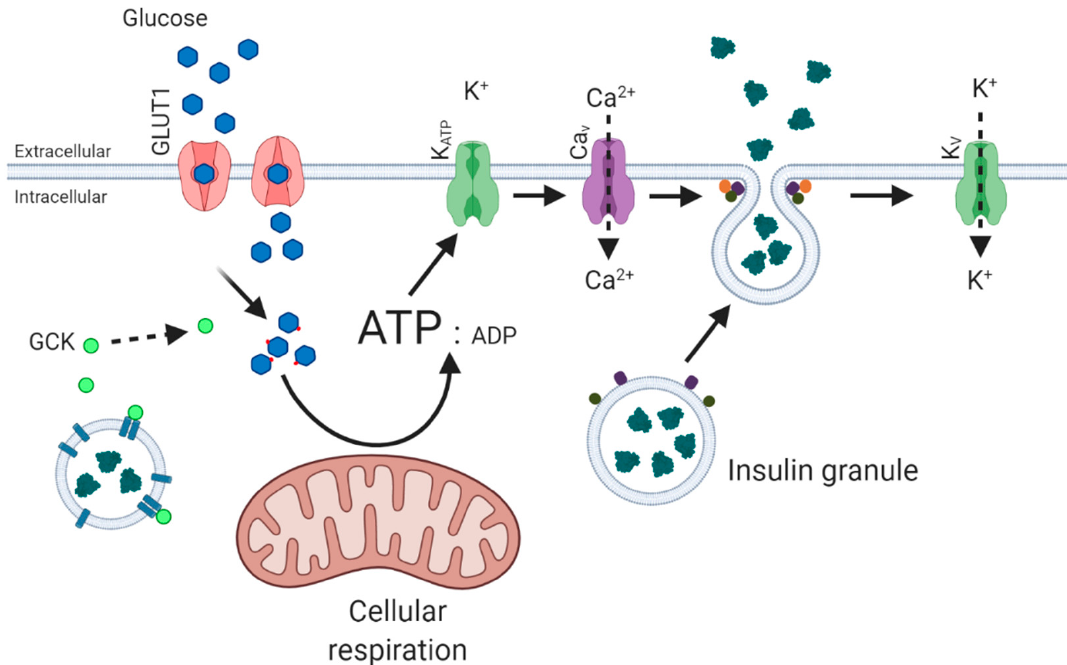
Figure 1. Glucose-stimulated insulin secretion from pancreatic beta cells. Glucose is imported via GLUT1 and phosphorylated by GCK. The increase in cellular respiration leads to an increase in the ATP/ADP ratio and the closure of K ATP channels and opening of Ca V channels. The entry of Ca 2+ ions prompts the fusion of insulin granules with the cell membrane, and this process is facilitated by SNARE complexes. Feedback signals after the return to glucose homeostasis leads to restoration of the membrane potential through the influx of K + ions through K V channels.